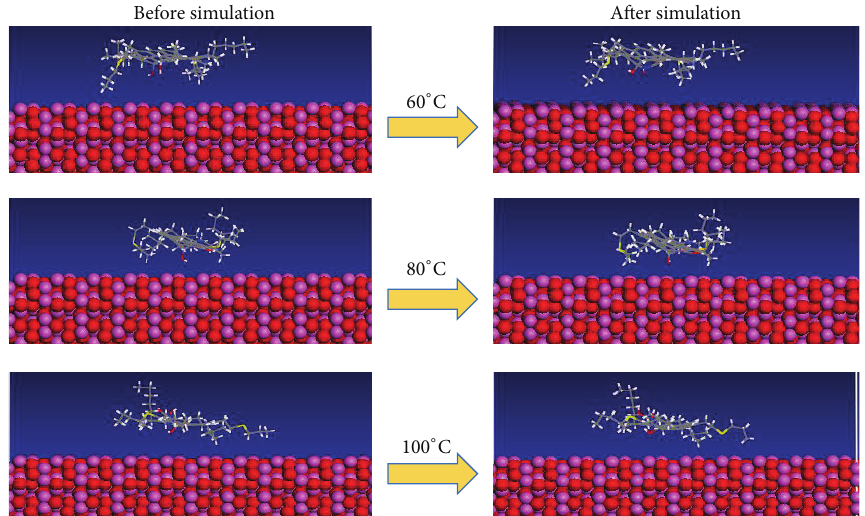
Figure 15: The interface configuration of asphaltene/Al 2 O 3 (60–100 ∘ C).